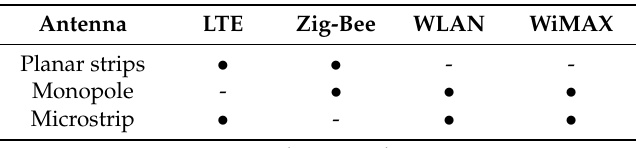
Table 6. Antenna solutions for